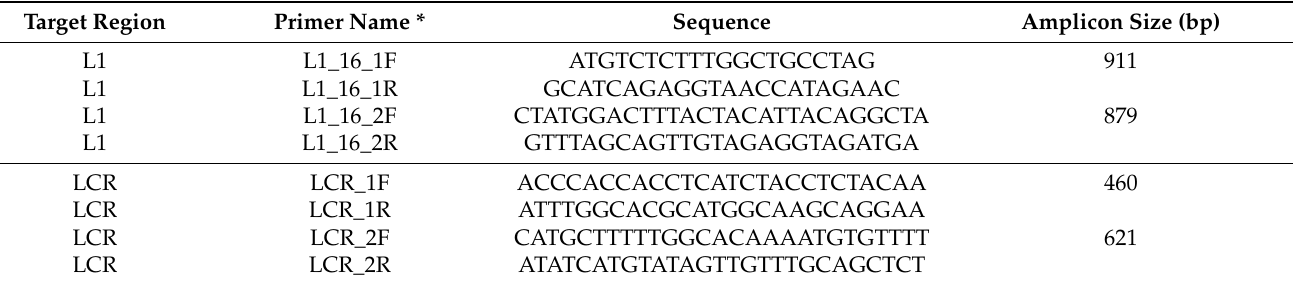
Table 1. Primer pairs for HPV16 L1 and LCR